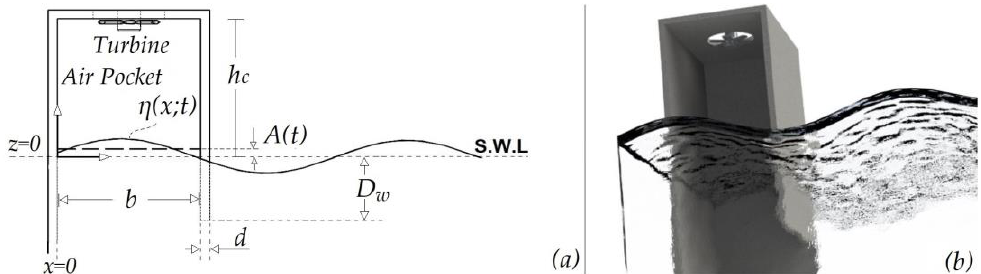
Figure 2. (a) Air pocket dynamics representation and OWC dimensions, (b) rendered view of the Figure 2. ( a ) Air pocket dynamics representation and OWC dimensions, ( b ) rendered view of the considered configuration. considered